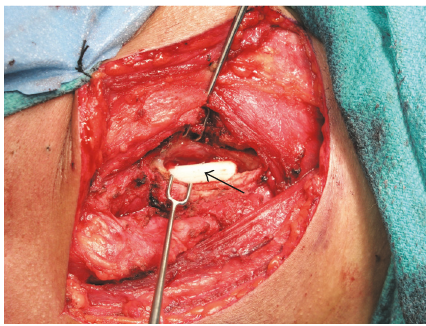
Figure 3: After raising subplatysmal flaps and entering a fibrous capsule, the toothbrush handle was visualized